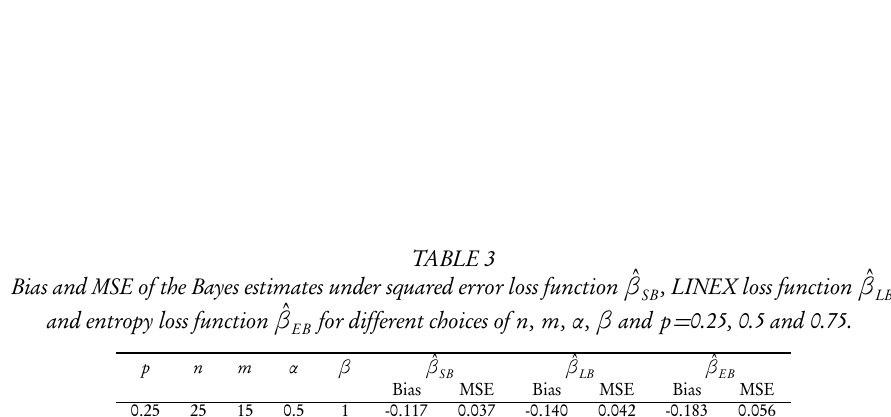
for different choices of n, m, α , β and p = 0.25, 0.5 and EB